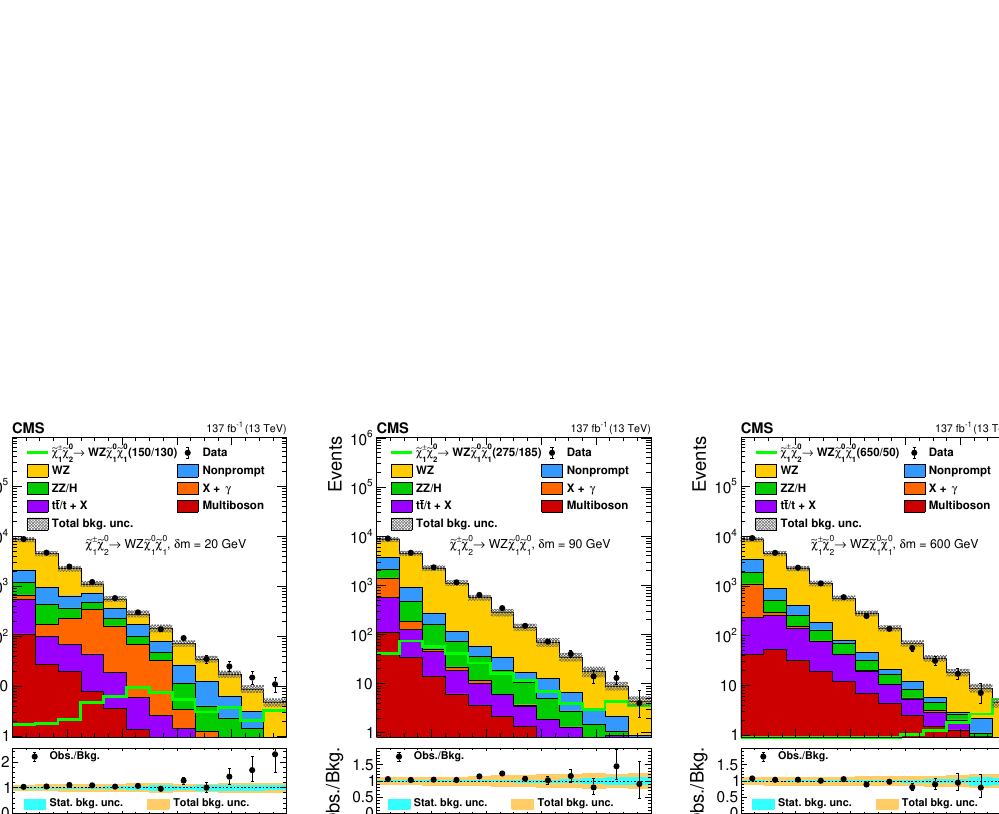
0 0 and for the shown signal e c e c 2 1